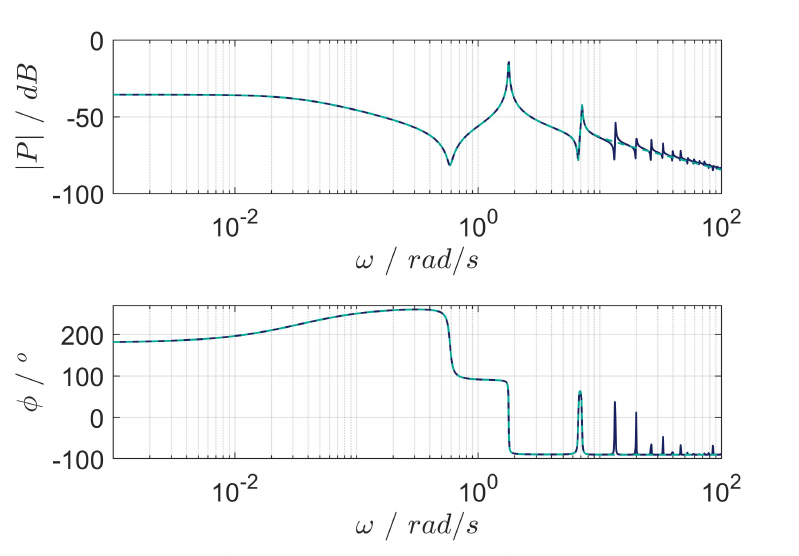
Figure 8. The Bode diagram of the linearized system. High-order model (solid blue); reduced order model (dashed